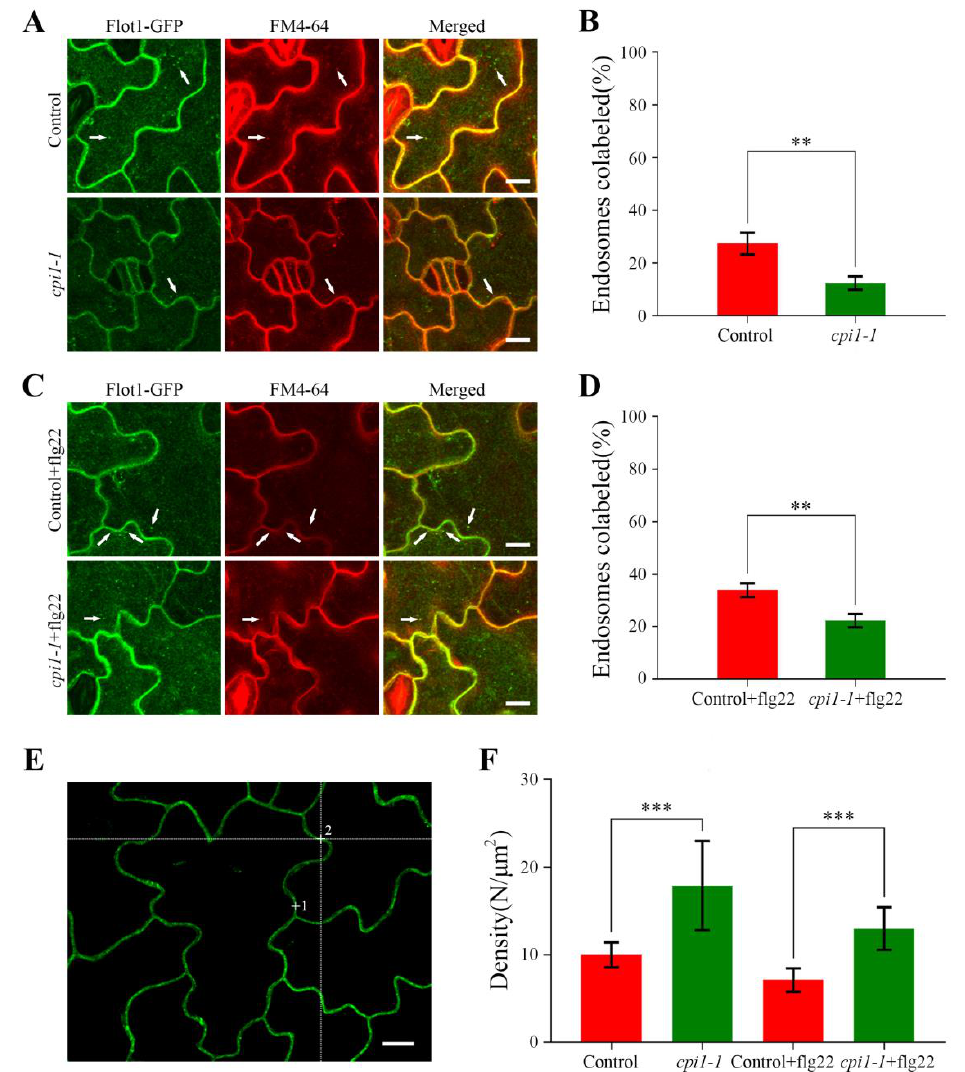
Figure 5. Confocal images showing endocytosis of Flot1-GFP in transgenic Arabidopsis lines. ( A ) Cotyledon epidermal cells were stained with FM4-64 and the endocytosis of Flot1-GFP and FM4-64 was observed in intracellular structures. White arrows indicate endosomes showing colocalization. Flot1-GFP is shown in green, FM4-64 in red, and the merged image indicating colocalization (yellow). Scale bar, 10 µ m. ( B ) Quantification of endosomes colabeled in control and cpi1-1 mutants cells. Data shown are from 27 to 42 plants. Error bars represent the SD ( n = 5–8). ** p < 0.01, Student’s t -test. ( C ) Cotyledon epidermal cells were treated with flg22 (10 µ M) for 60 min, followed by staining with FM4-64 for 30 min. The endocytosis of Flot1-GFP and FM4-64 was observed in intracellular structures. Flot1-GFP colocalized with FM4-64 was observed in the endosome (white arrow). Scale bar, 10 µ m. ( D ) Quantification of endosomes colabeled in control and cpi1-1 mutants cells after flg22 treatment. Data shown are from 28 to 38 plants. Error bars represent the SD ( n = 5–8). ** p < 0.01, Student’s t -test. (E) Typical confocal image. The laser beam was focused on points 1 and 2 to monitor the fluorescence fluctuations. Scale bar, 10 µ m. ( F ) The density of Flot1-GFP particles on the plasma membrane of cotyledon epidermal cells after di ff erent treatments. Data shown are from 32 to 47 plants. Error bars represent the SD ( n = 4). *** p < 0.001, Student’s t -test. To further probe whether the sterols affect the function of Flot1 in plant immunity, we analyzed the endocytosis of Flot1-GFP in cpi1-1 mutants after pretreatment with flg22 for 60 min and